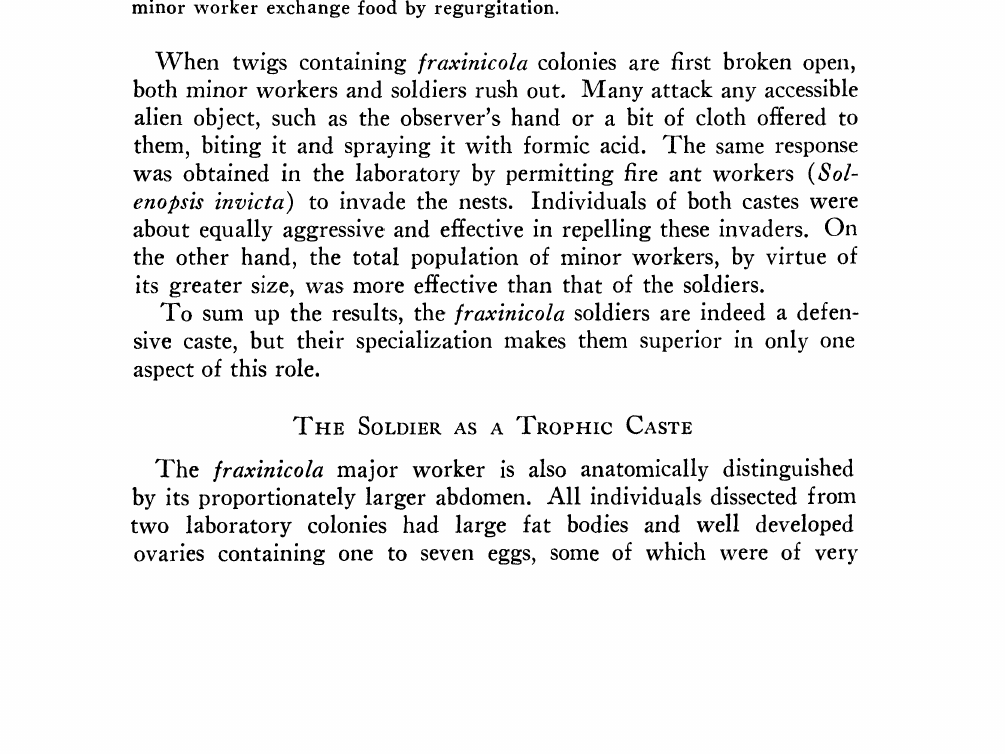
Figure 1. Portion of a laboratory colony of Camponotus (Colobopsis) fraxinicola housed in a glass tube. The large soldiers use their cylindrical heads to block the circular nest entrances, which are cut by the minor workers. This colony has been fed ad libitum, and consequently both soldiers and minor workers are in replete condition. In the center, a soldier and minor worker exchange food by